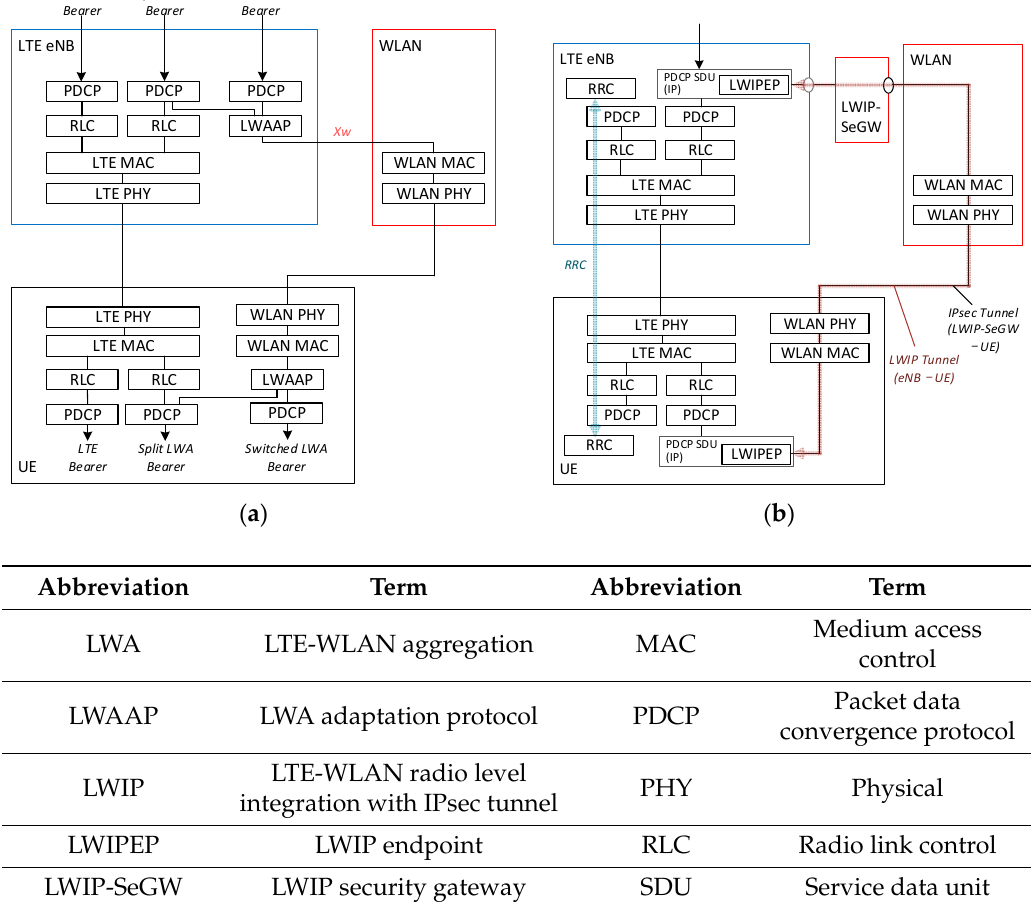
Figure 4. LTE-WLAN interworking architectures in Release 13: ( a ) LTE-WLAN aggregation (LWA)